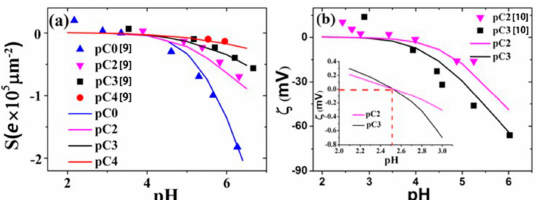
Figure 3. ( a ) Calculated surface charge density plotted as a function of pH values with a channel radius of 20 µ m (solid lines). Experimental data [9] are shown as filled symbols. Excellent theory–experiment agreement is seen. The pC values indicate the salt concentration; i.e., those surface-non-specific ions that are excluded by the surface potential trap. ( b ) Zeta potential plotted as a function of pH values under di ff erent salt concentrations pC, with a channel radius of 20 µ m. Theory predictions are shown as the solid lines, and experimental data are shown as filled symbols [10]. Semi-quantitative agreement is seen. The inset shows an enlarged view of the zeta potential at around pH 2–3. The zeta potential is seen to cross zero at the same isoelectronic point, pH 2.5, for two di ff erent salt concentrations. All the solid curves were calculated with γ = 510 mV. Adapted from